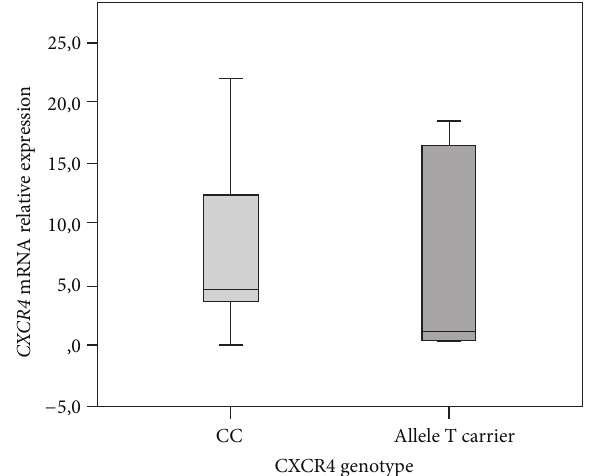
Figure 3: CXCR4 mRNA relative expression in accordance with rs2228014 genetic polymorphism. The Mann-Whitney test demon- stratedthatCXCR4mRNAlevelsdidnotdiffersignificantlybetween CC patients (mean 7.7 ± SE 5.65) and allele T carriers (mean 6.4 ± SE 8.64) ( 𝑝 = 0.301 ). Error bars as 95% IC.